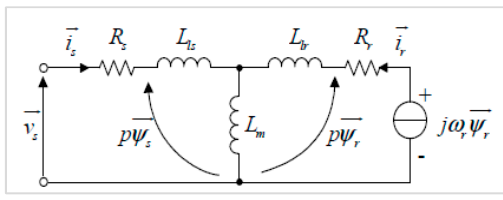
Figure 1. 𝛤 Model of an induction machine [20]. Figure 1. Γ Model of an induction machine